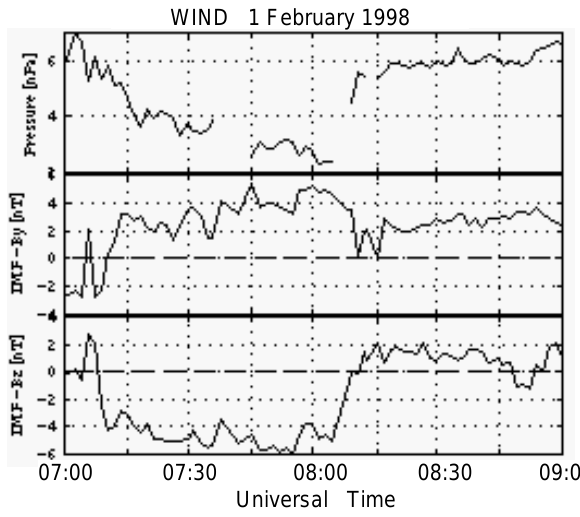
Fig. 3. The solar wind dynamic pressure and IMF components B Y and B Z (in GSM coordinates) measured by Wind during the 07:00 to 09:00UT